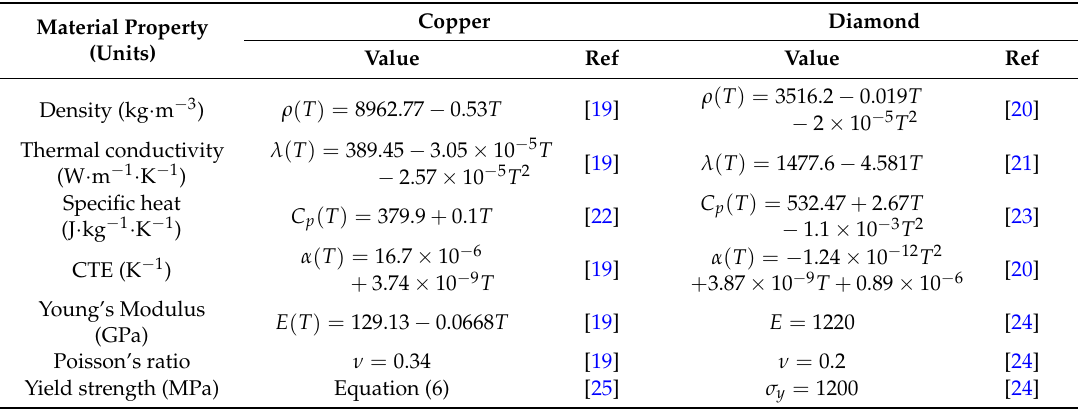
Table 2. Material Properties of the Cu-matrix and diamond